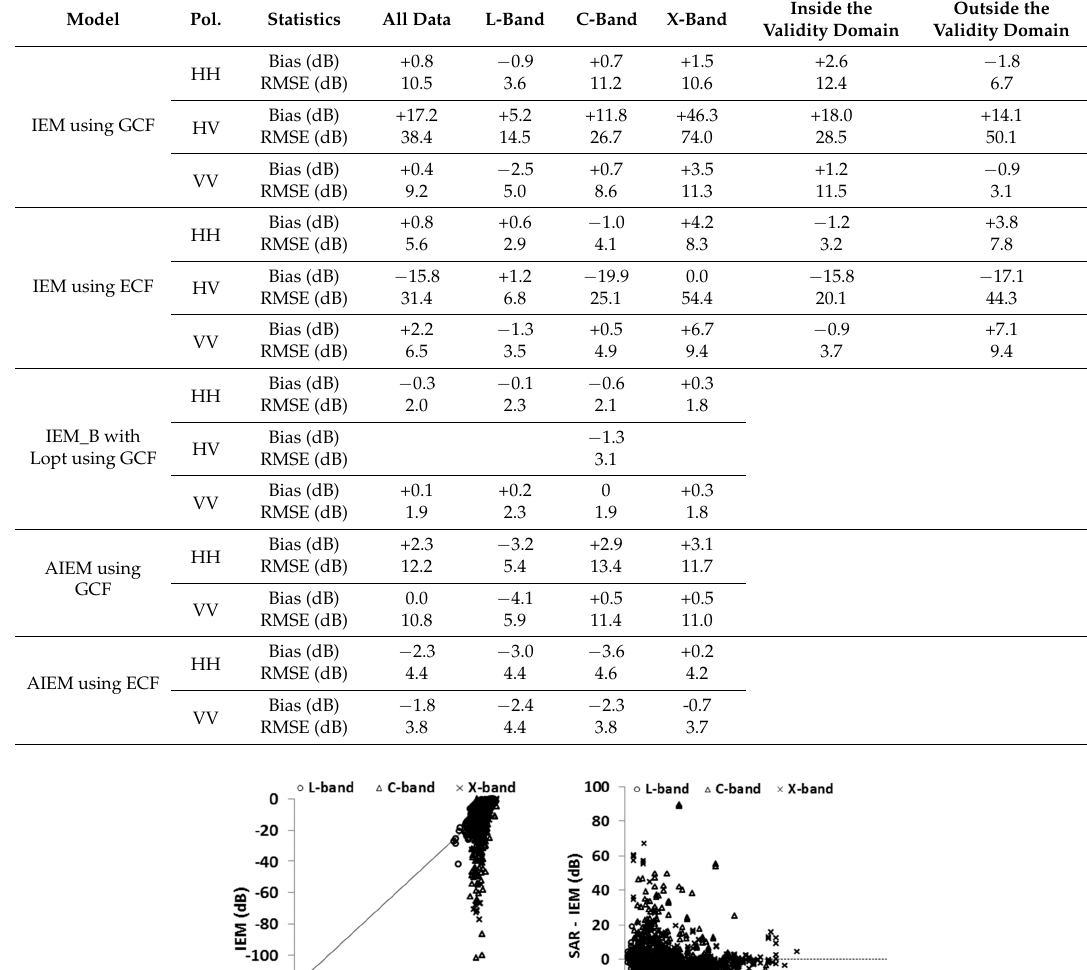
Inside the Outside the Validity Domain Validity Domain